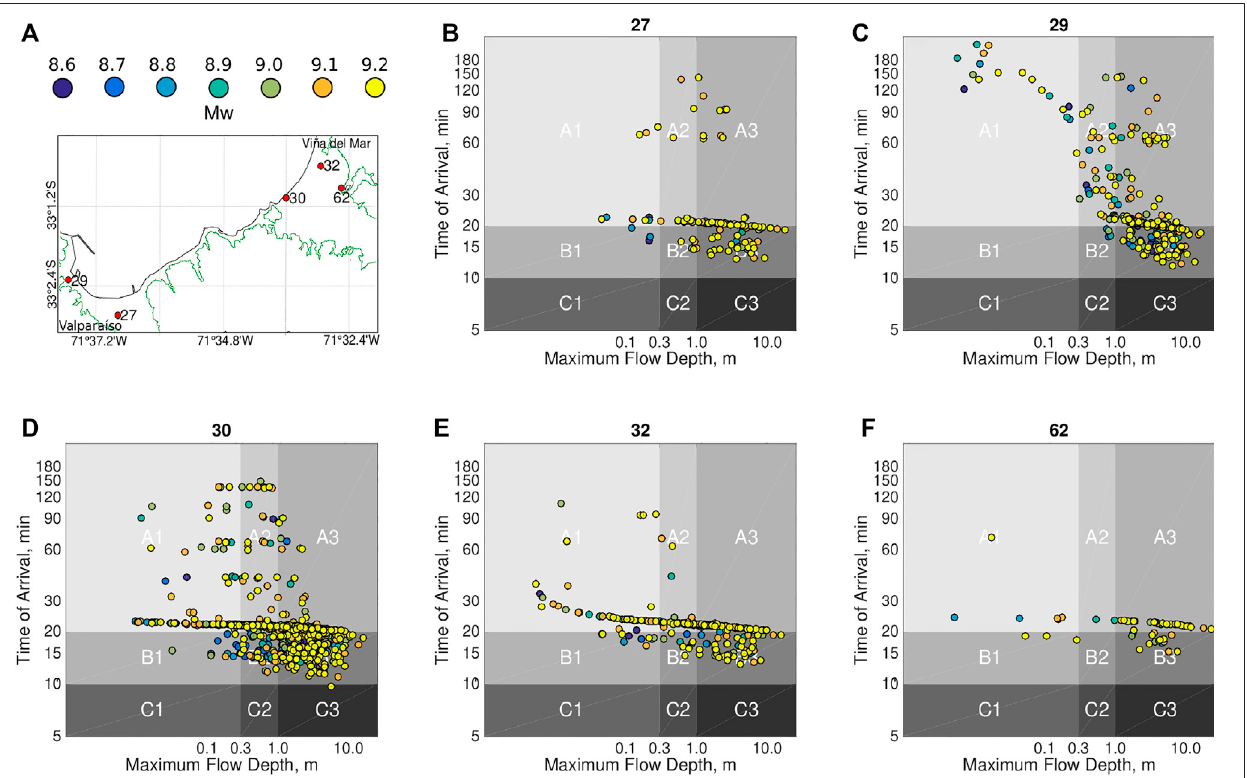
FIGURE 10 | Scatter plots of earliest arrival time against maximum fl ow depth, color coded by M w from blue ( M w 8 . 6 ) to yellow ( M w 9 . 2 ) M w (A) Location of selected points of interest shown in red. The black line is the coastline, and the green line stands for the 30 m a.s.l. contour. The background color indicates the categorizationfor fi ve selectedpoints ofinterestshown withred circles inthemap (B) Pointofinterest ID 27 (C) Pointofinterest ID 29 (D) Pointofinterest ID30 (E) Point of interest ID 32; and (F) Point of interest ID